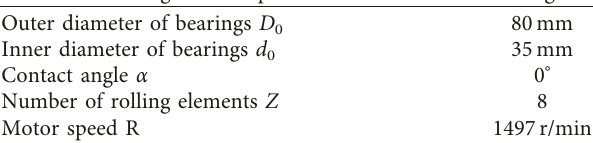
Table 2: The geometric parameters of the tested